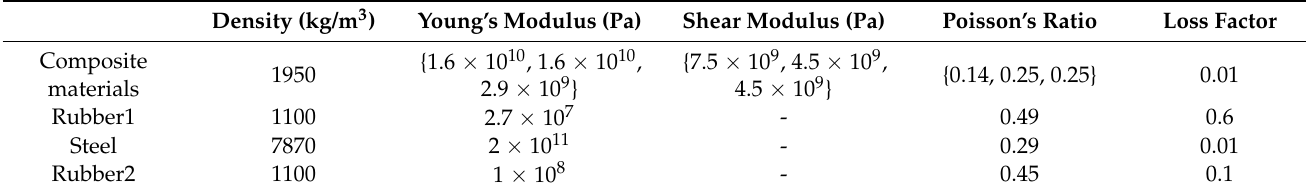
Table 1. The property parameters of the